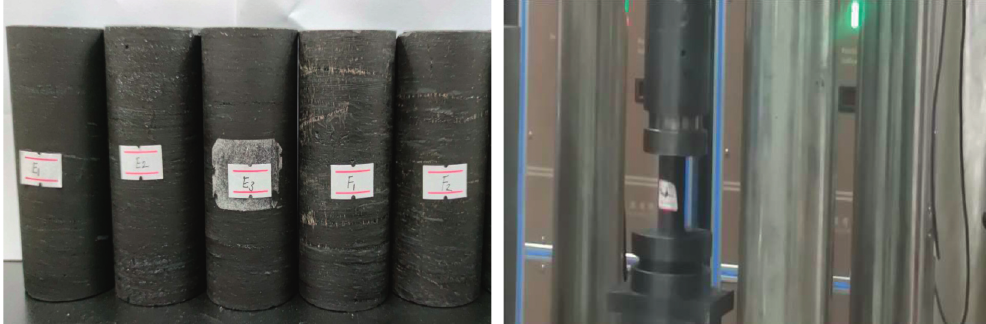
Figure 10: WAW31000 microcomputer-controlled electrohydraulic servo testing machine.